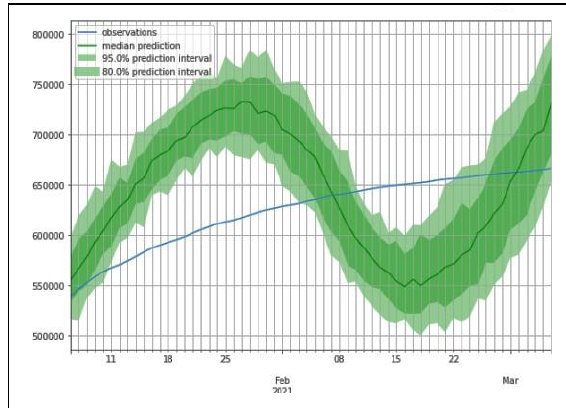
Fig.11. DeepAR with GRU cells “testing data” Table 3. MAPE AND RMSE comparison of all